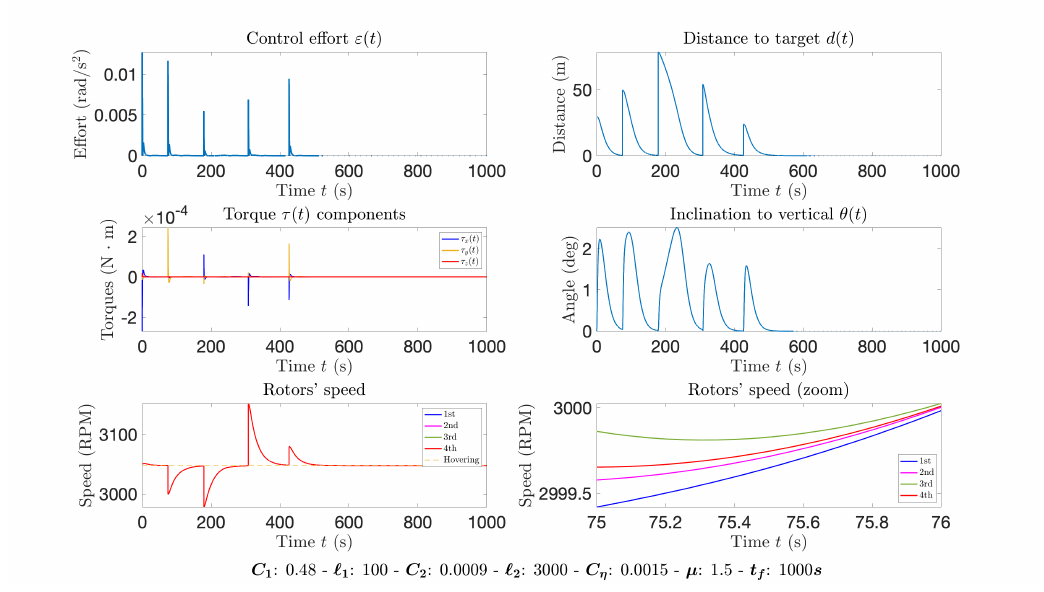
Figure 14. Experiment: Multiple shifting targets, second set of VARP parameters. ( a ) Target approaching trajectory; ( b ) Control figures.